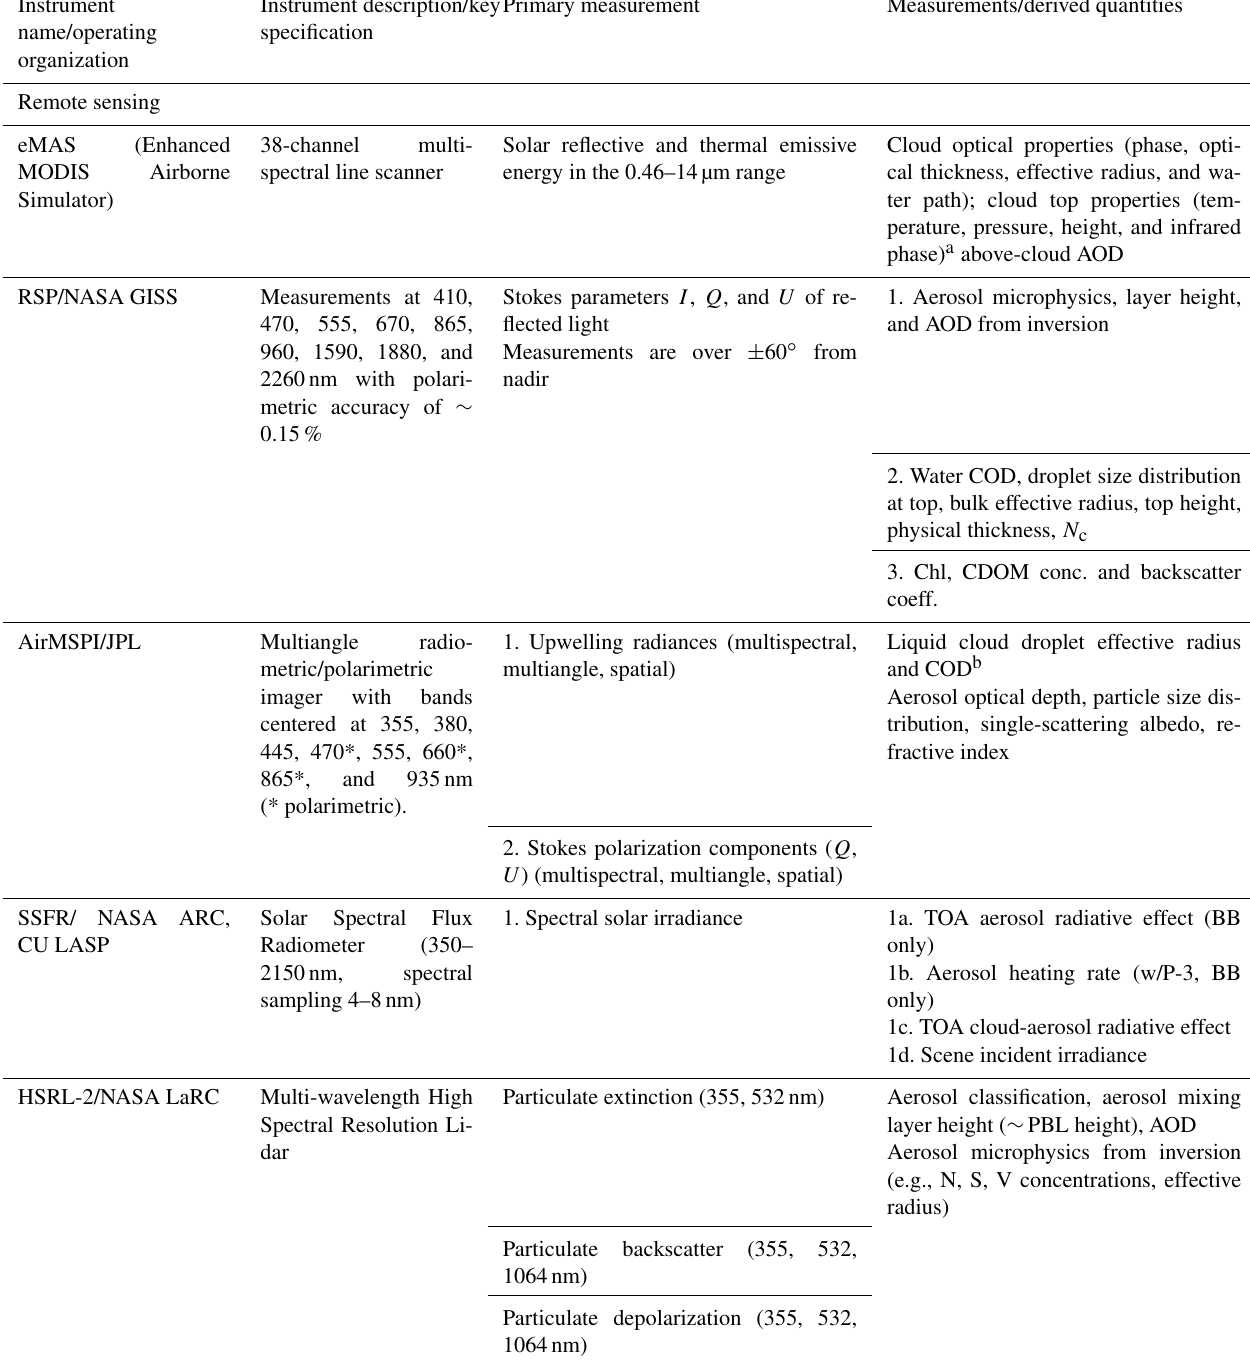
Table B2. ER-2 instruments in ORACLES